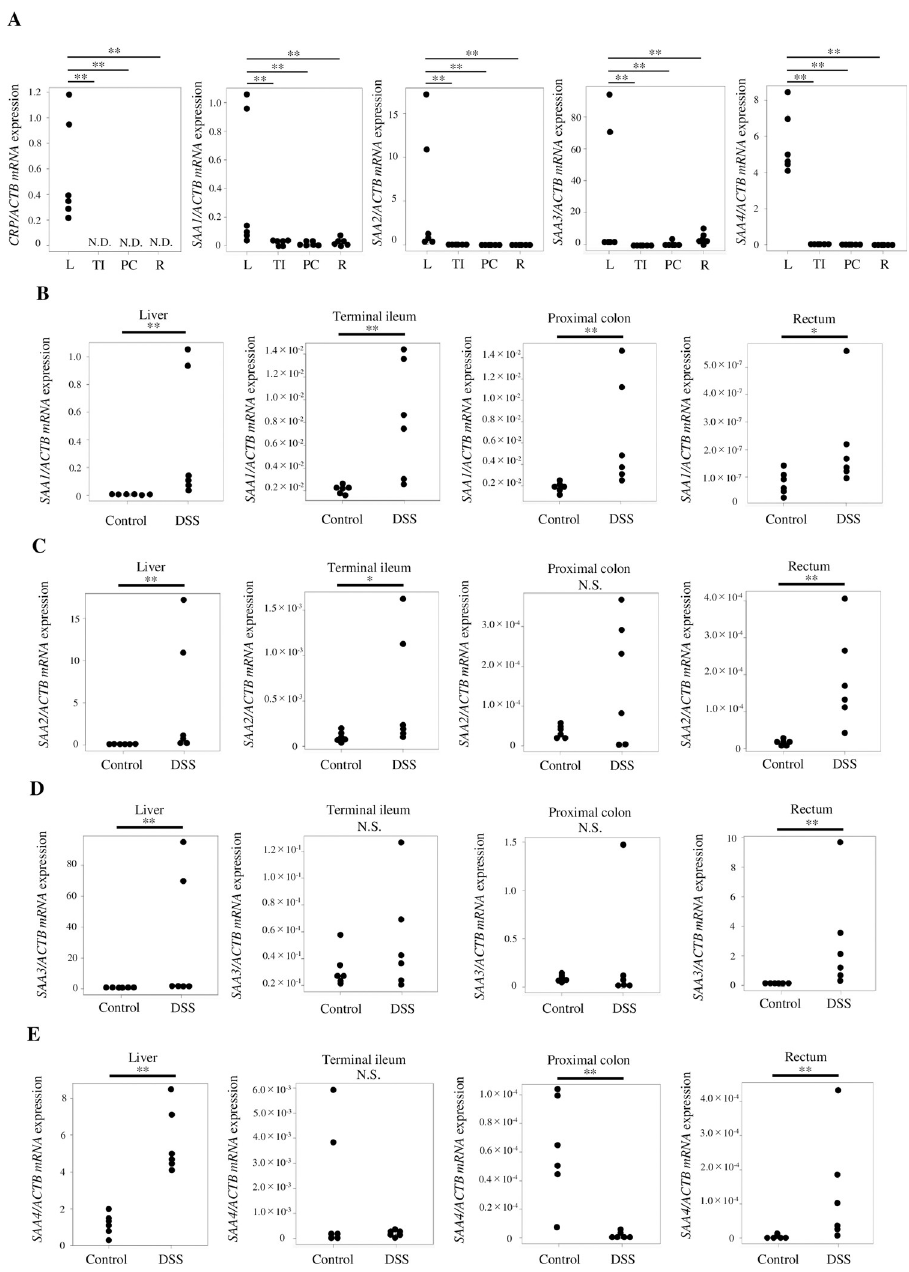
Fig 1. Expression of SAA1-4 / CRP in the liver and intestine of mice with dextran sulfate sodium (DSS)-induced colitis. (A) Normalized CRP and SAA expression levels in the liver and each part of the intestinal tract 7 days after DSS administration. (B) After DSS administration, SAA1 expression level increased in the liver, terminal ileum, ascending colon, and rectum when compared to untreated controls. (C) SAA2 was significantly upregulated in organs other than the ascending colon. (D) SAA3 expression level was significantly increased in the liver and rectum but not in the terminal ileum and ascending colon. In particular, SAA3 expression level was strongly increased in the rectum. (E) SAA4 expression was significantly upregulated in the liver and rectum. On the contrary, in the ascending colon, treatment with DSS suppressed the expression of SAA4 . Data are represented as the mean ± standard deviation (n = 6) upon normalization to ACTB expression. �� P < 0.01 and � P < 0.05 versus untreated controls. N.D., not detected; L, liver; TI, terminal ileum; PC, proximal colon; R, rectum.